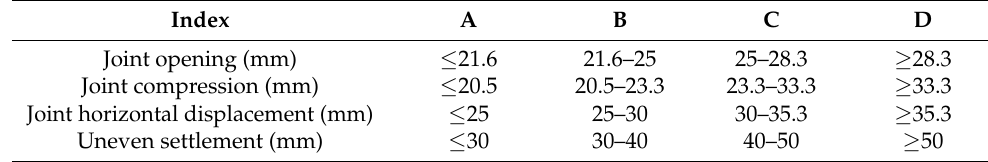
Table 3. The graded warning thresholds of Honggu tunnel (revised according to Hu et al. [31]).